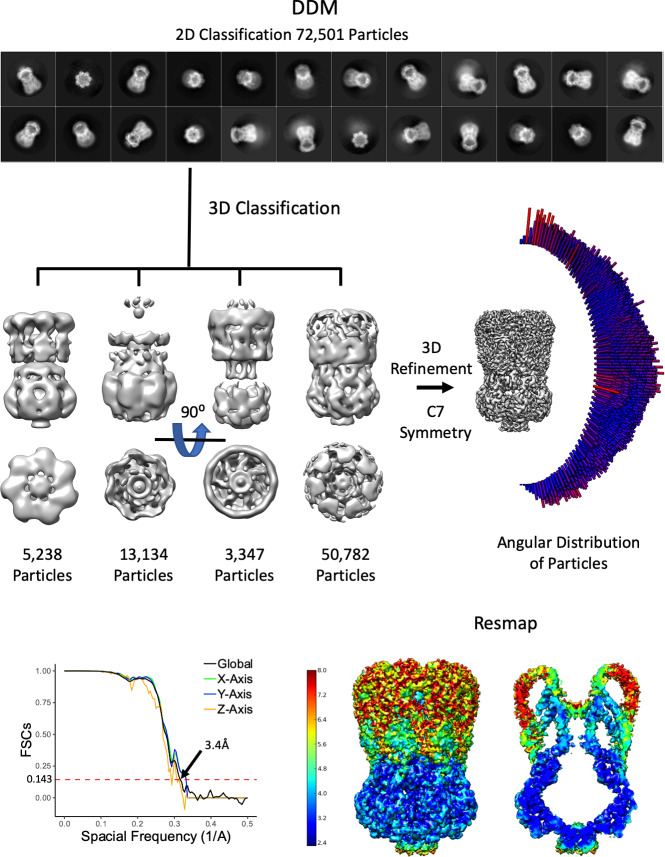
Overview of MscS DDM Density Refinement.From 1328 movies, 72,501 particles were used after 2D classification. The selected 2D classes were subjected to a 3D classification where truncated (possibly denatured due to the air-water interface) particles were classified out. The final reconstruction used only the 3D class with the entire molecule. As can be seen in the 2D classes, the angular distribution of particles and the 3D FSC (Tan et al., 2017) there are multiple orientations.